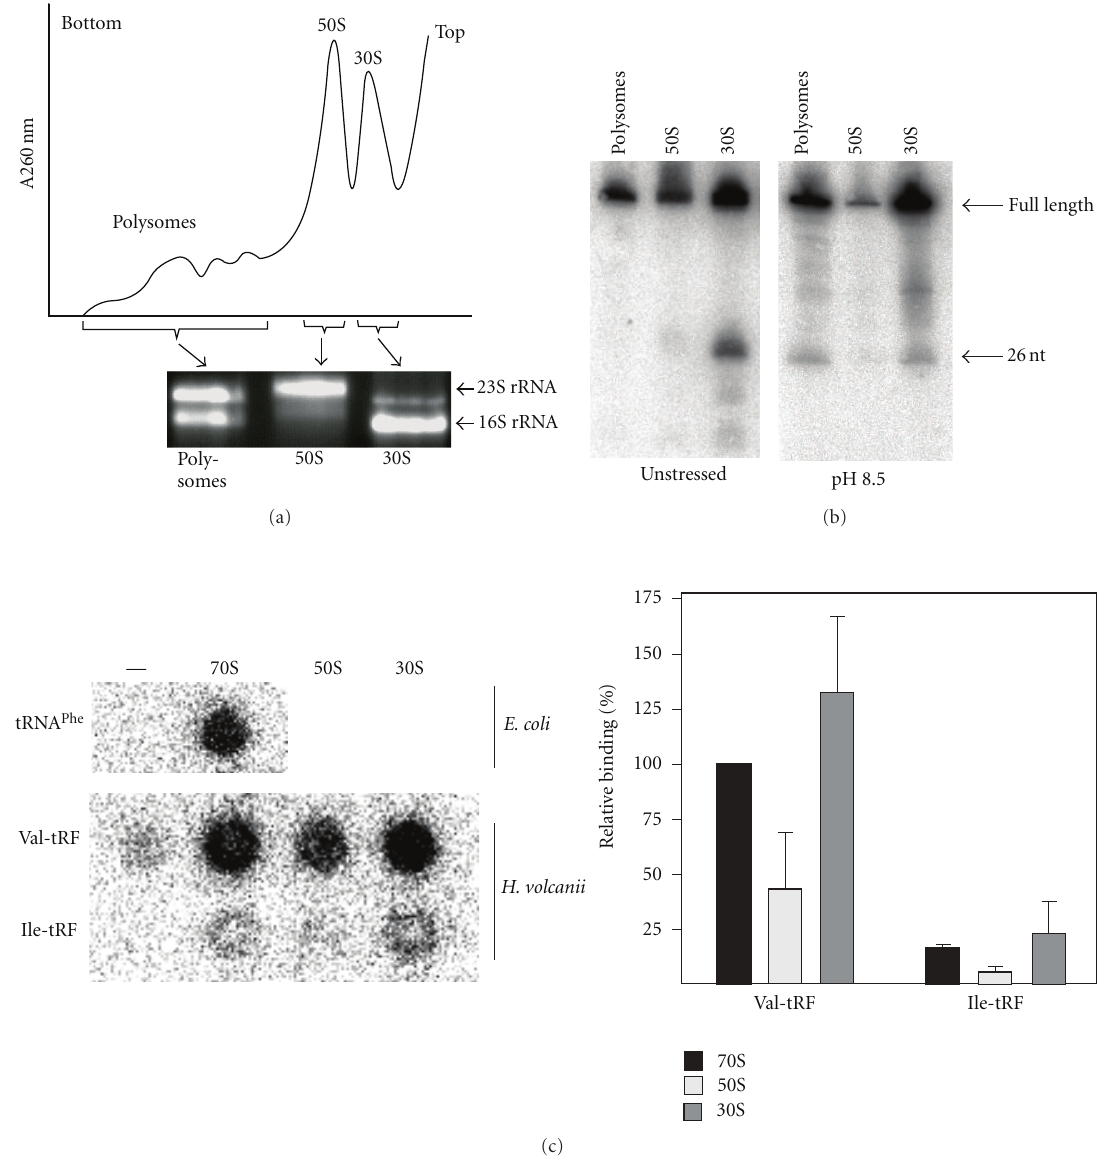
Figure 3: Val-tRF associates with ribosomes in vitro and in vivo. (a) A representative polysome gradient of H. volcanii. Fractions containing polysomes, 50S, or 30S subunits were collected and used for northern blot analyses. The identity of the individual fractions was confirmed by agarose gel electrophoresis. (b) The presence of the Val-tRF in the di ff erent gradient fractions was investigated by northern blot analysis using RNA from unstressed cells or from cultures incubated at high pH (pH 8.5). Arrows indicate the full-length Val-tRNA and the 26 nt long fragment detected in the cDNA library. (c) In vitro filter binding studies of radiolabelled synthetic Val-tRF on ribosomal particles (70S, 50S, 30S) from H. volcanii (left panel). As a positive control, binding of tRNA Phe to E. coli 70S was monitored. To confirm specific binding of Val-tRF an equally long fragment of isoleucine tRNA (Ile-tRF), an RNA sequence not found in our cDNA screen, served as negative control. (Right panel) Quantification of relative binding whereas association of Val-tRF to 70S was normalized to 100%. Signals measured in the absence of any ribosomal particles (-) were subtracted from all experimental points. Error bars show the mean and standard deviation of at least four independent